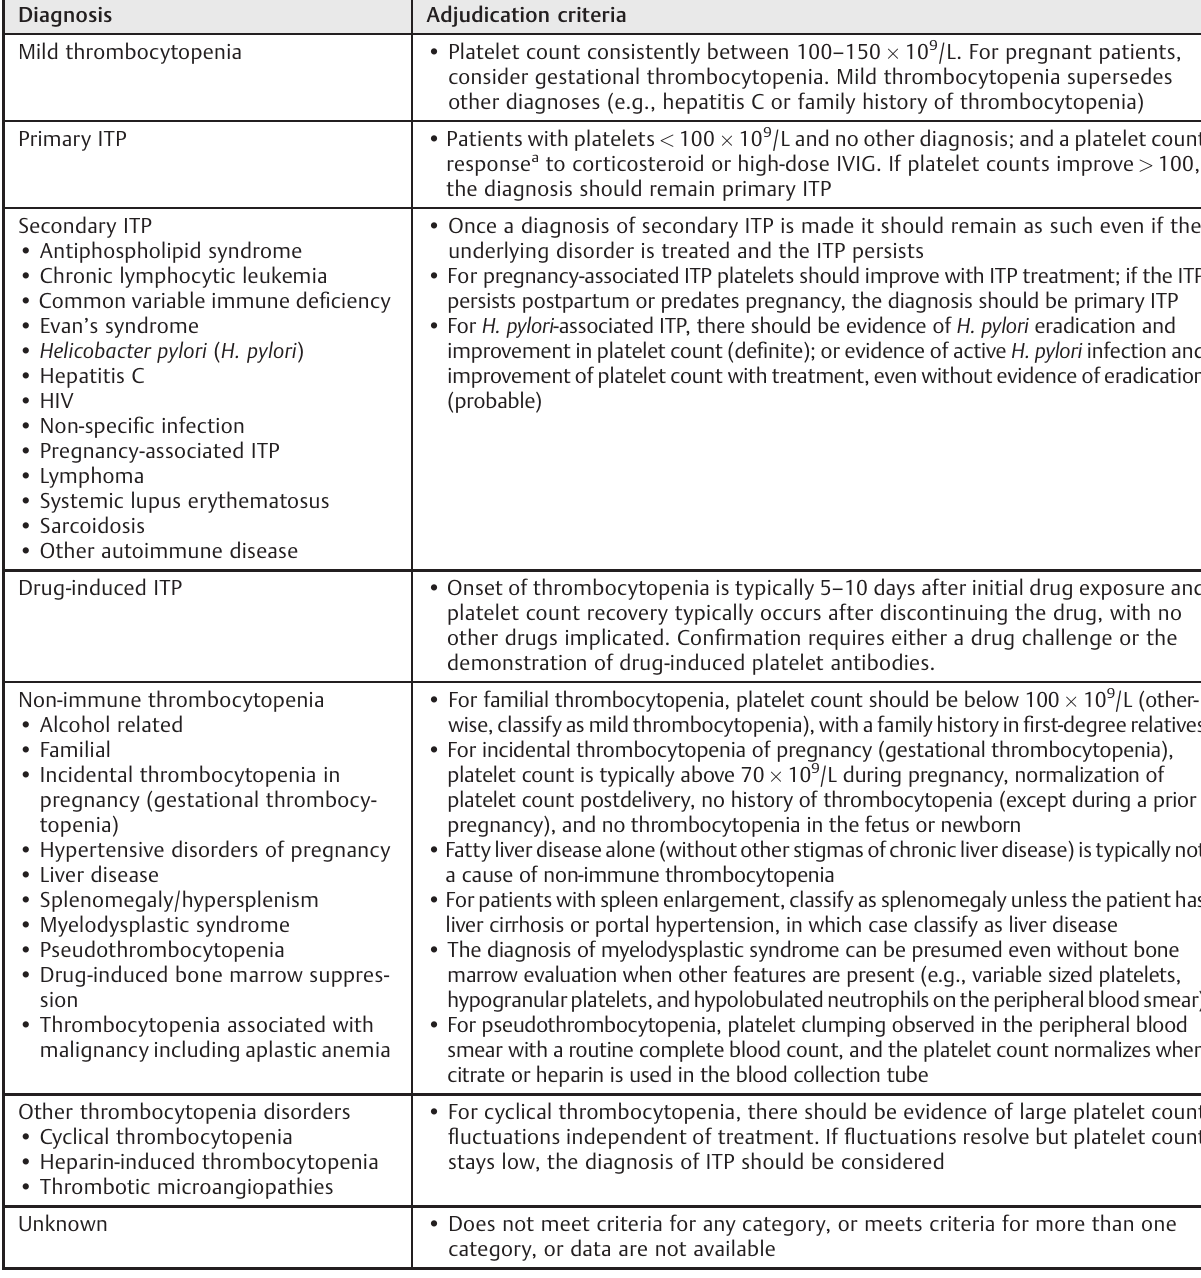
Table 1 Adjudication criteria for the diagnosis of thrombocytopenia Diagnosis Adjudication criteria Mild